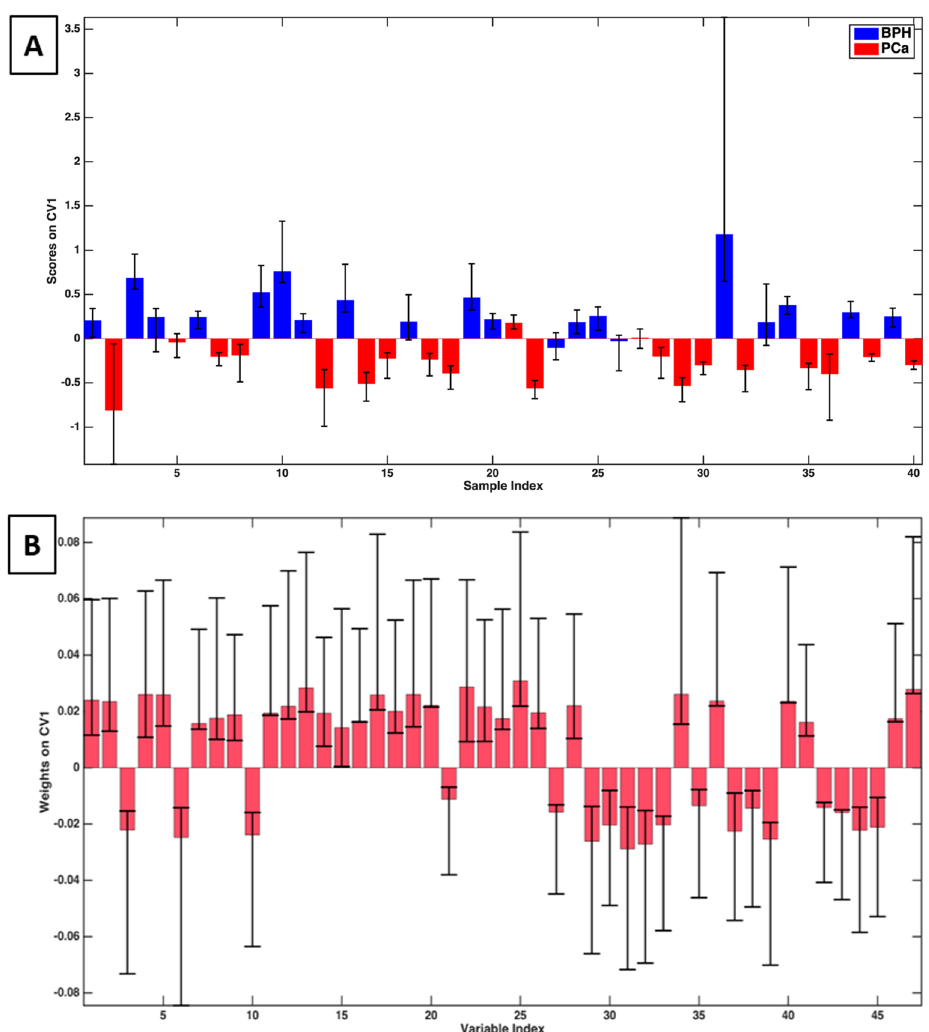
Figure 5. Graphical representation of the r-dCV model obtained for the ESI– dataset. ( A ) Scores of the samples along the first canonical variable. ( B ) Weights of the variables along the first canonical